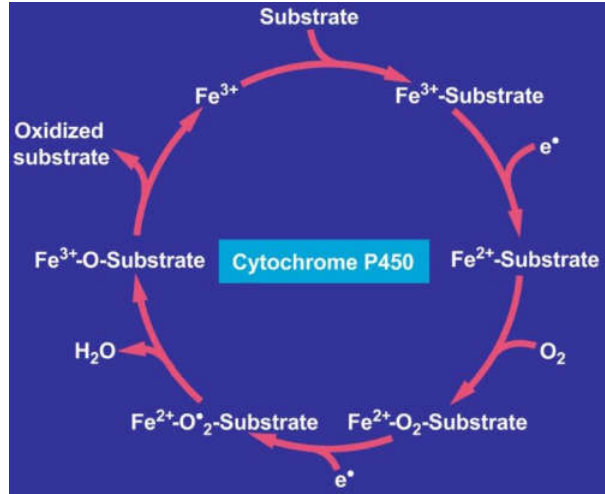
Figure 4. Hepatic microsomal cytochrome P450 and its interaction with substrates. Cytochrome P450 catalyzes the oxidation of substrates such as drugs and ethanol, which bind to the ferric (3 + ) iron of the cytochrome P450 as the initial metabolic step leading finally to the oxidized substrate. The original figure was published in a recent article [257].